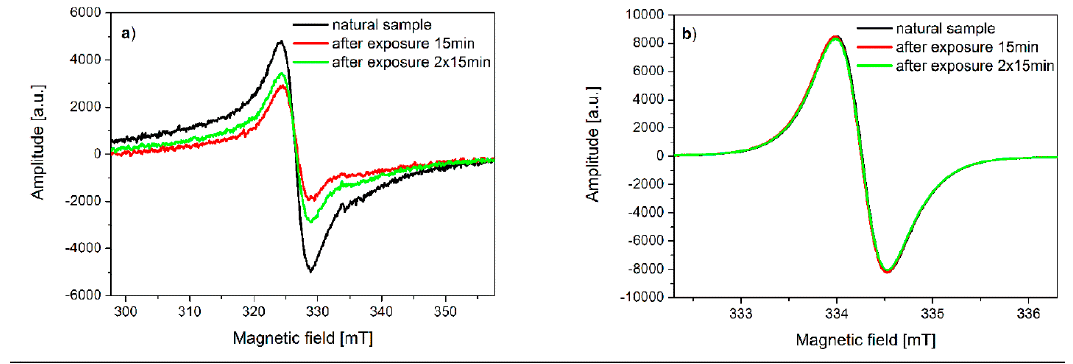
Figure 6. Exemplary electron spin resonance (ESR) spectra: ( a ) for 1%CuPc@TiO 2 (15 nm) and ( b ) for ZnPc.